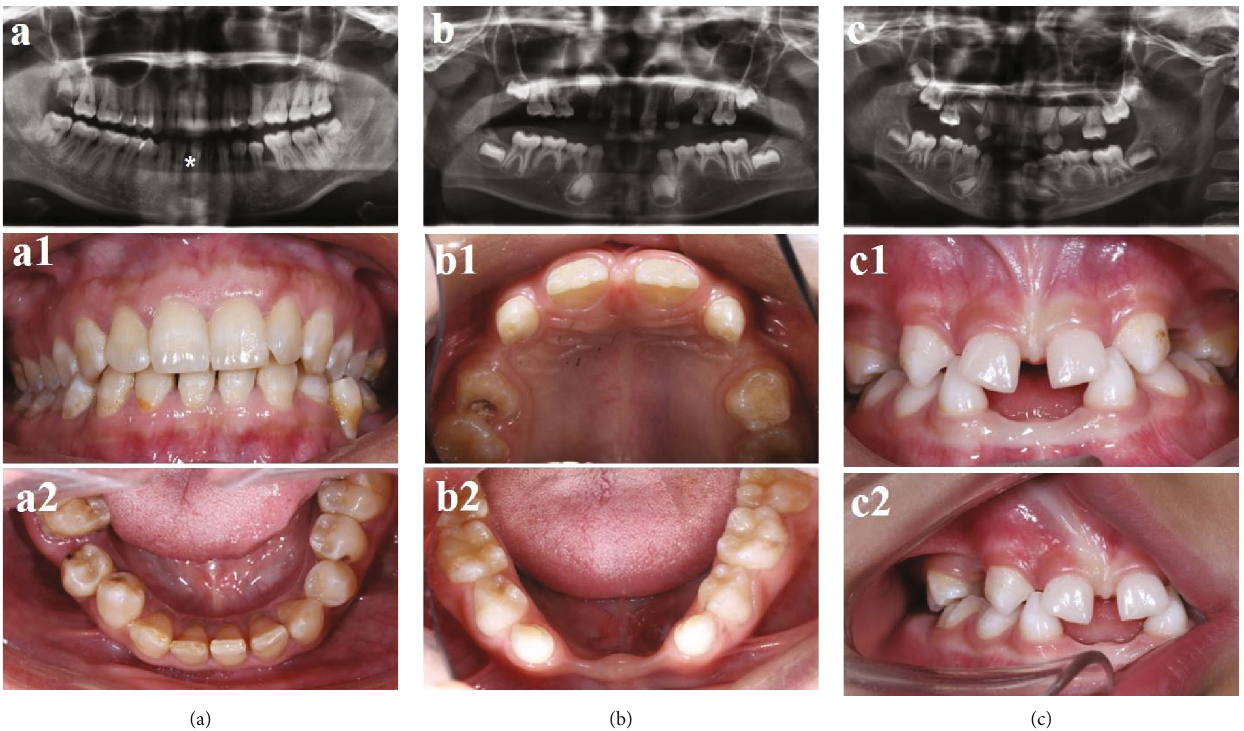
Figure 2: Dental phenotype and panoramic radiographs of the patients. (a – c) Panoramic radiographs of II:2, III:1, and III:2. (a1, a2; b1, b2; c1, c2) Intraoral photos of II:2, III:1, and